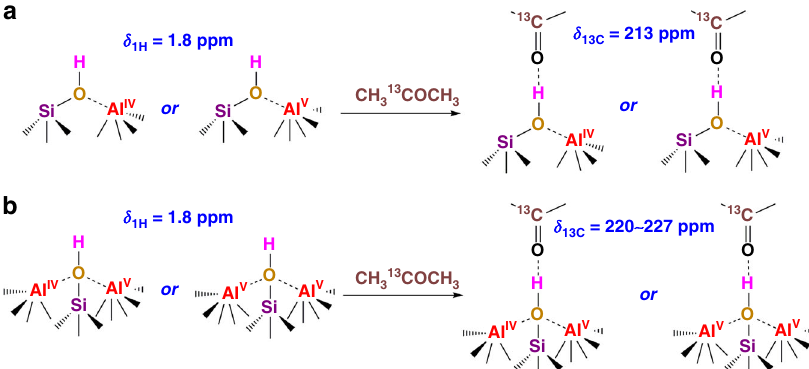
Fig. 4 Proposed models for BAS on ASA generated by. a one Al center per SiOH for moderate BAS, and b two Al centers per SiOH group, leading to moderate or zeolitic acidity strengths. The acid strength is estimated by measuring the 13 C isotropic chemical shift of CH 3 13 COCH 3 , which is loaded on dehydrated samples on a vacuum line, followed by evacuation at room temperature for 1 h to remove weakly